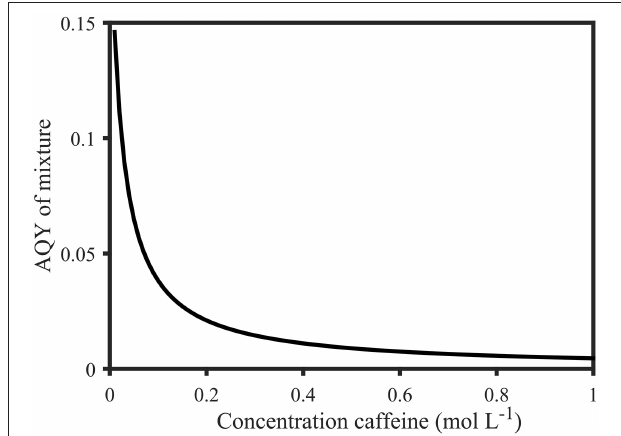
FIGURE 9 | Calculated apparent quantum yields of a mixture of 1 mol L − 1 salicylic acid solution with variable molar parts of caffeine (0.01–1 mol L − 1 ) at 258nm. The apparent quantum yield decreases from 0.15 (0.01mol L − 1 caffeine) to 0.0046 (1mol L − 1 caffeine). Calculations were based on Equation (5) and are explained in the Supplementary